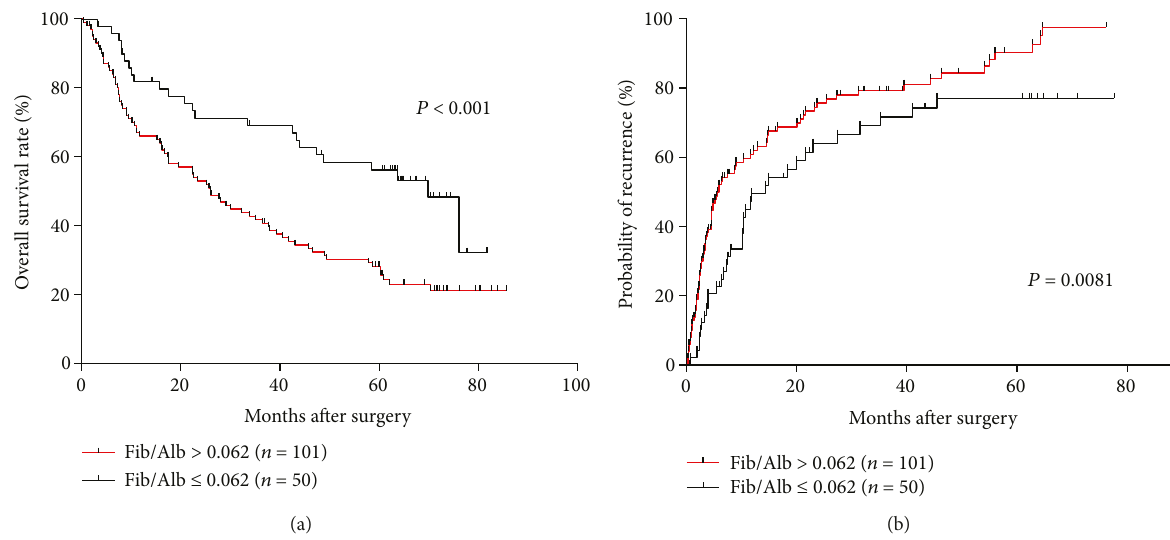
Figure 3: Kaplan – Meier curves of overall survival and recurrence are shown for HCC patients. (a) OS of patients with a Fib/Alb ratio > 0.062 was signi fi cantly shorter than that of those with a Fib/Alb ratio ≤ 0.062 ( P < 0 001 , log-rank test). (b) Recurrence rate of patients with a Fib/ Alb ratio > 0.062 was signi fi cantly higher than that of those with a Fib/Alb ratio ≤ 0.062 ( P = 0 0081 , log-rank test).